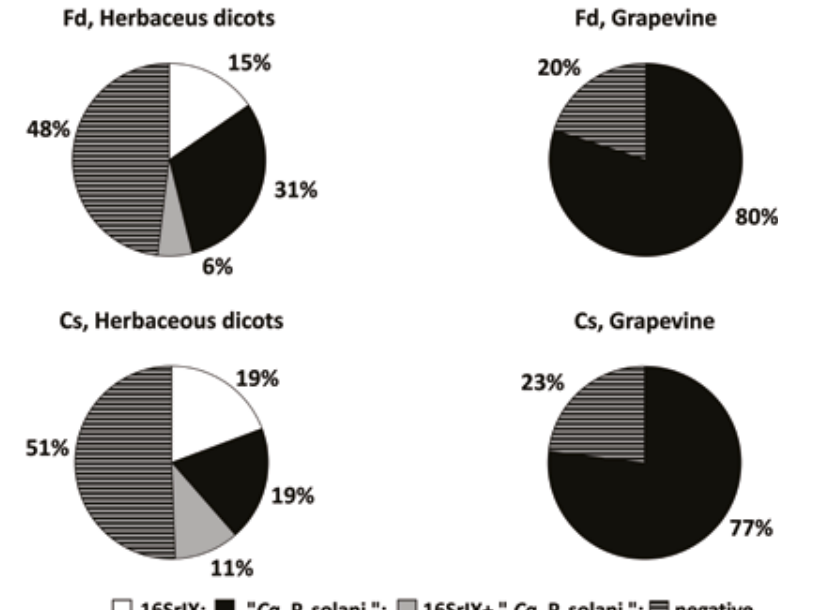
Figure 1. Overall results of PCR indexing for “ Ca . P. solani”, “ Ca . P. vitis” “ Ca . P. asteris” (real-time PCR) and for the phy- toplasmas of the ribosomal group 16SrIX (nested PCR) carried out in October 2010 on single symptomatic grapevines and wild herbaceous dicot plants growing in vineyard plots Fd and Cs. All specimens tested negative for “ Ca . P. vitis” and “ Ca . P.